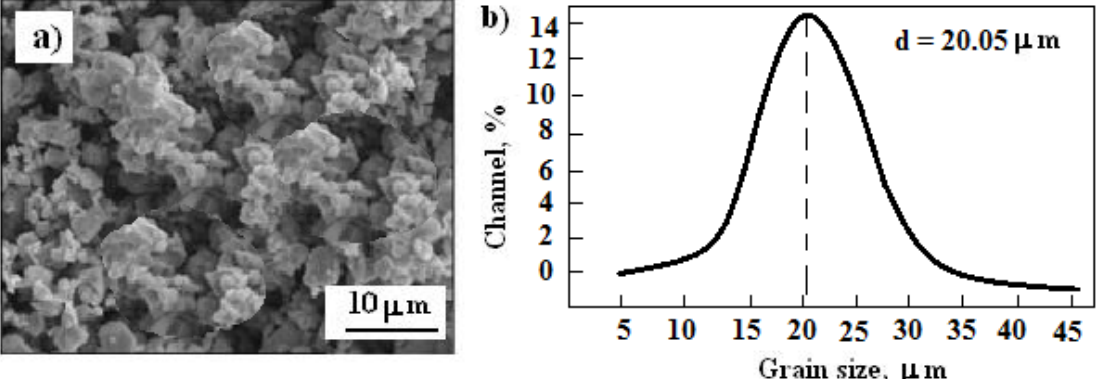
Figure 1. Scanning electron microscopy image: ( a ) structure of the Cr 3 C 2 -25(Ni20Cr) powder, ( b ) powder grain size distribution analysis.